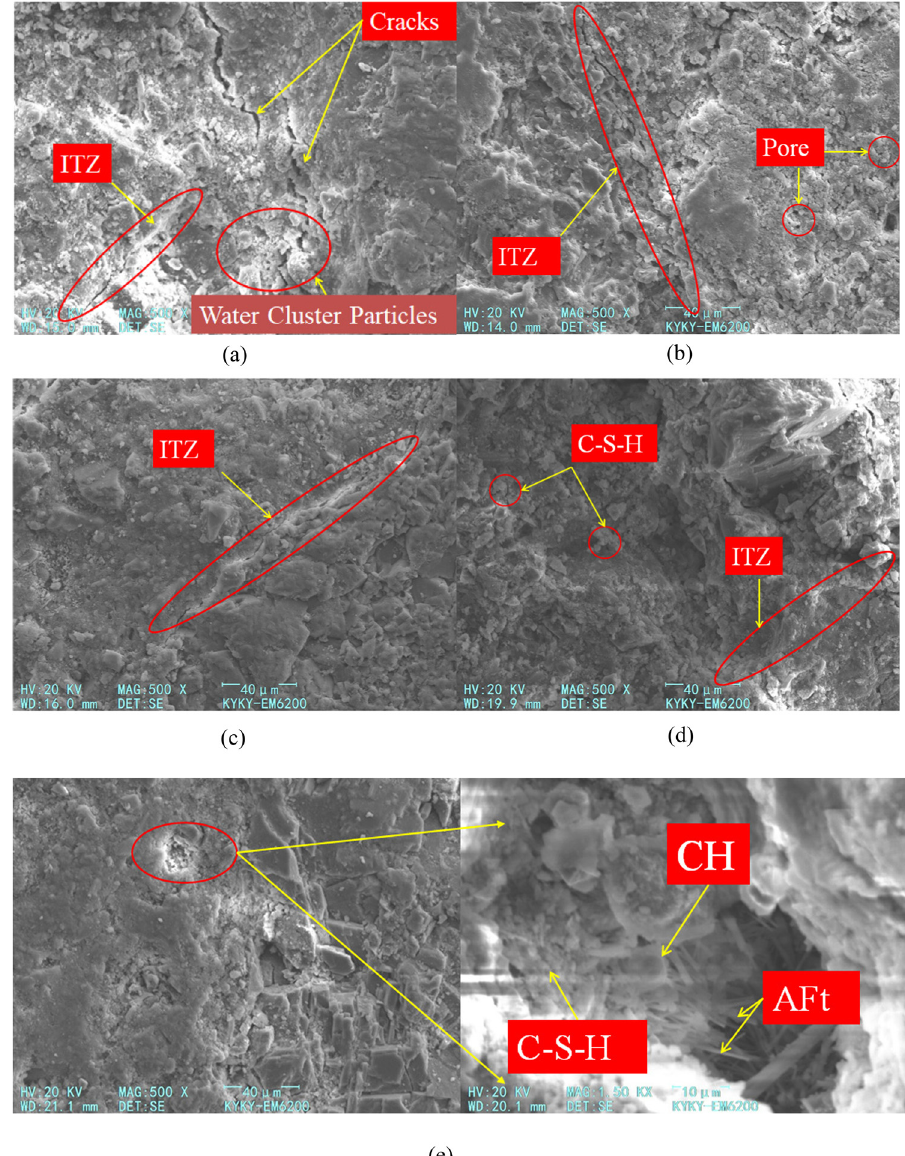
Figure 8: Microstructure of RAC. ( a ) N - P, ( b ) C - P, ( c ) C - Z, ( d ) CP2 - 2, and ( e ) CZ2 -